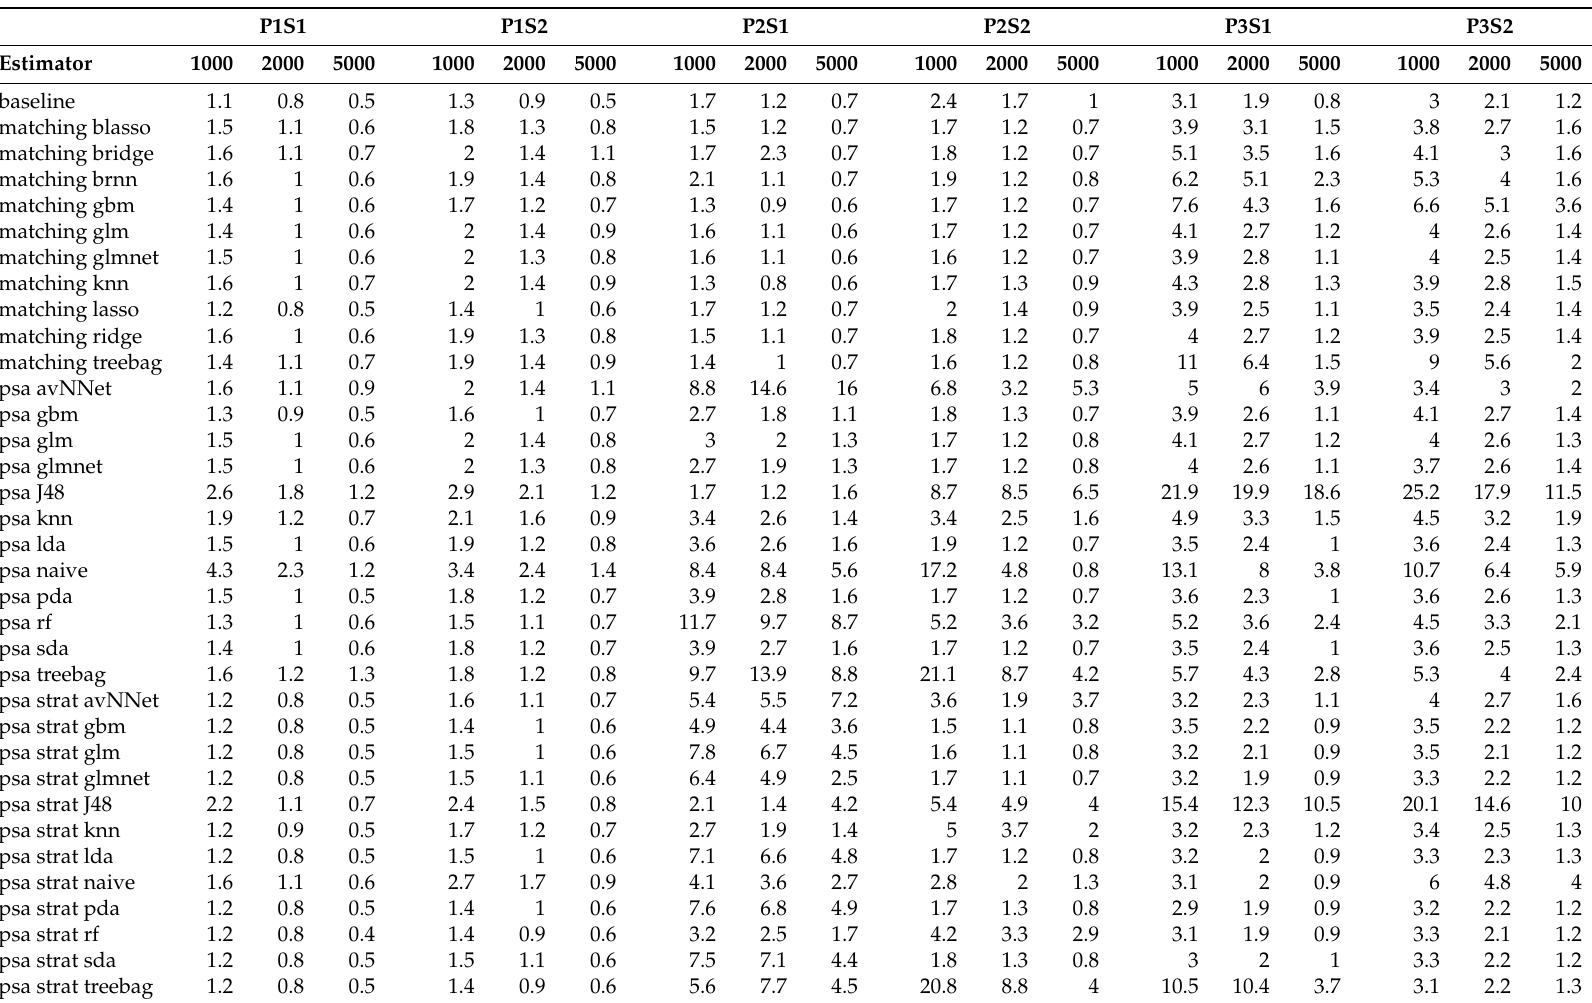
Table A2. Relative deviation (%) of each estimator for each population, sampling method, and sample size. The best values among the methods are in